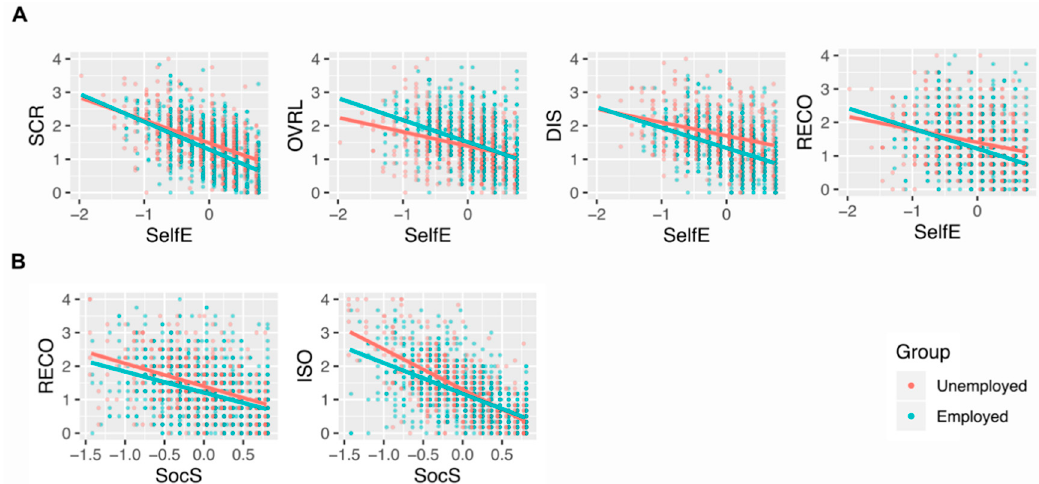
Figure 1. Di ff erential associations of external (social) and internal (psychological) resources with facets of chronic stress in employed and unemployed youth. ( A ) The association of self-esteem (Self E) (FamS) with di ff erent facets of chronic stress is more pronounced in employed youth. ( B ) The association of social support (SocS) with di ff erent facets of chronic stress is more pronounced in unemployed youth. SCR = chronic stress screening, OVRL = stress due to work overload, DIS = stress due to occupational discontent, RECO = stress due to lack of social recognition, ISO = stress due to social isolation. Data of unemployed adolescents are illustrated in red, data of employed adolescents in green.